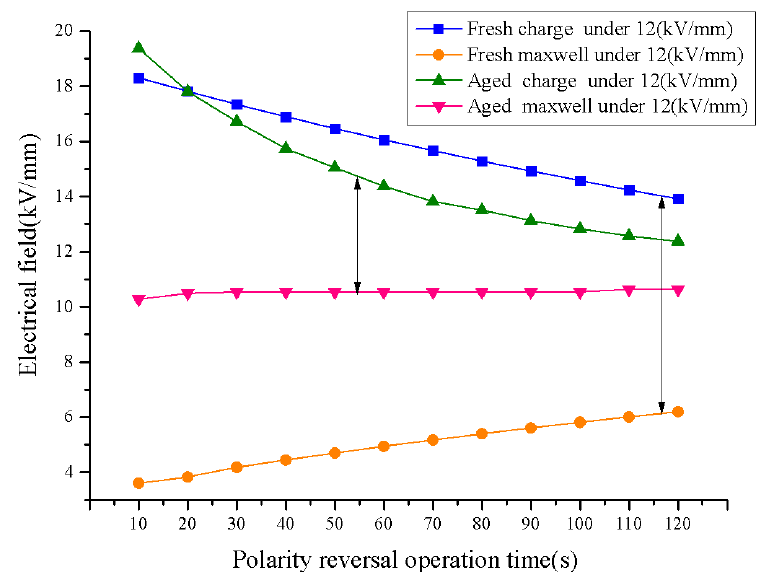
Figure 37. Electric field distribution of both fresh and aged oil ‐ impregnated pressboard caused by space charge and Maxwell theory for different polarity reversal operation time.